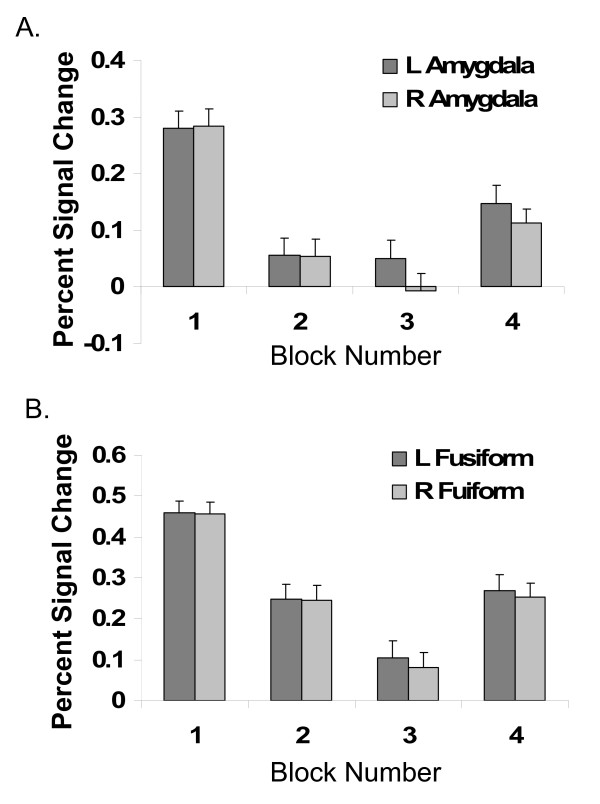
Temporal dynamics of responses to facial expressions yield "U" pattern. Percent signal change in brain activity in response to facial expressions compared to baseline across blocks in A) Amygdala and B) Fusiform Gyrus. L = Left, R = Right. Small bars indicate one standard error of the mean.